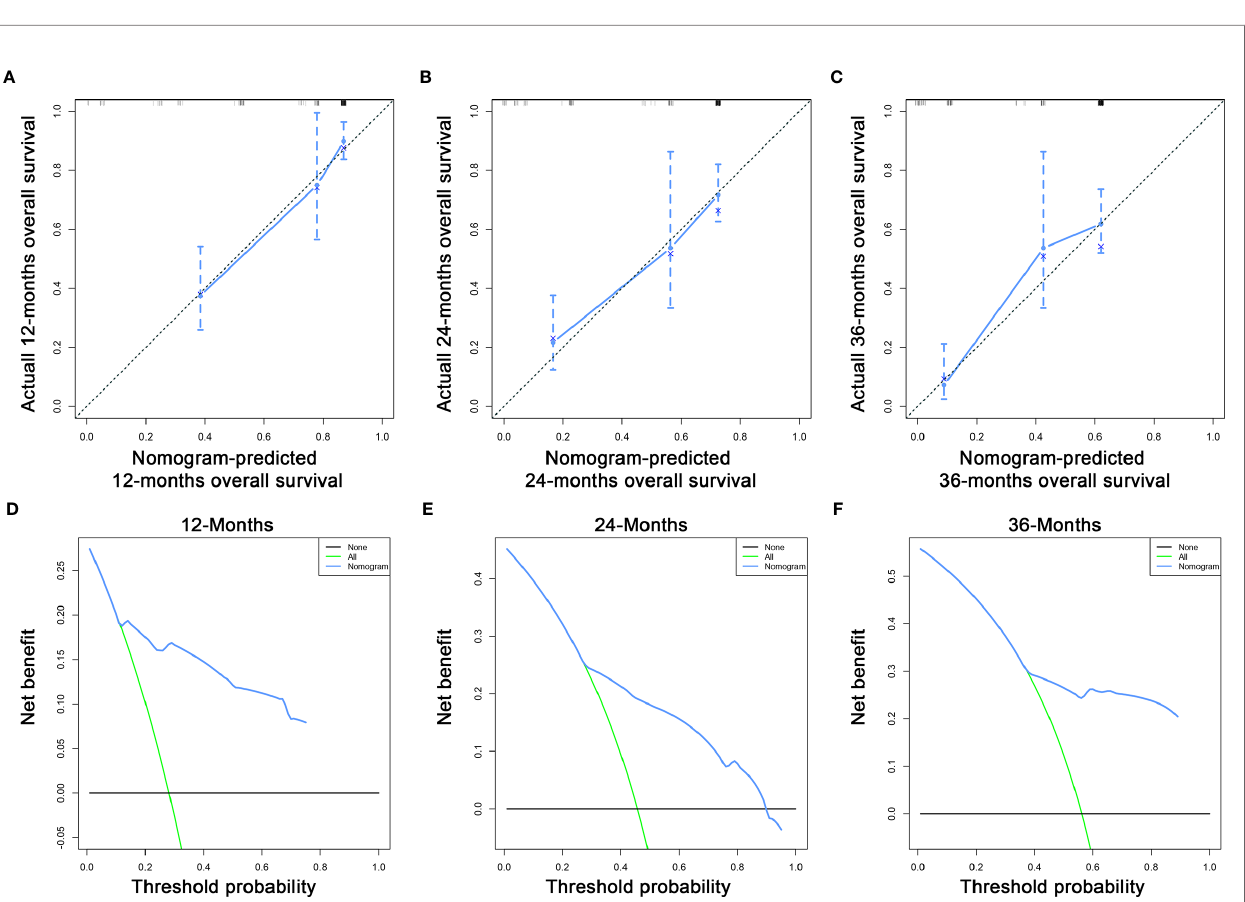
FIGURE 4 | The calibration curves of the nomogram for the 12 (A) , 24 (B) , and 36 months (C) in the training set. The decision curve analysis of the nomogram for the 12 (D) , 24 (E) , and 36 months (F) in the training